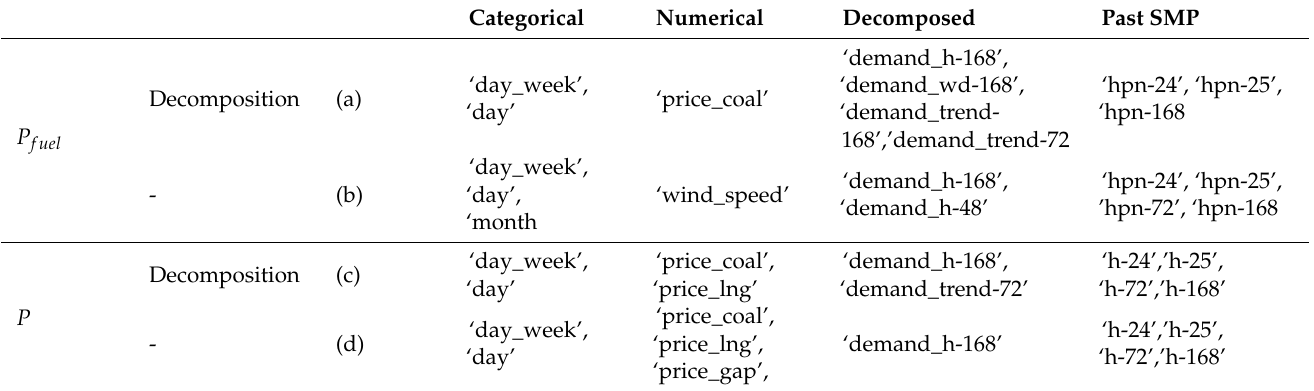
Figure 6. Calculate rank as forecasting ( a ) P fuel ( c ) P . Without decomposed data, calculate gains as forecasting ( b ) P fuel ( d ) P . Table 2. Selected Features for each case at case study 1.